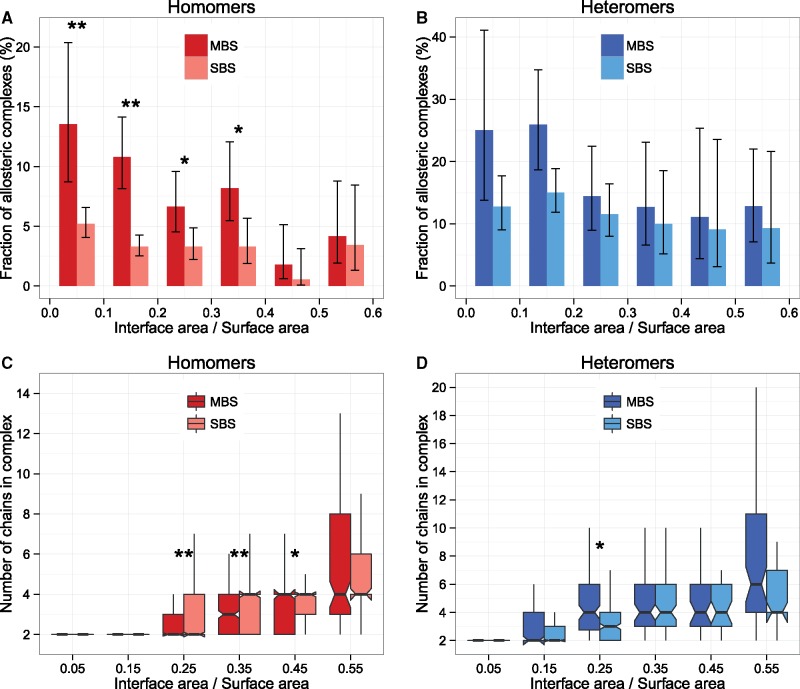
Allostery is more frequent in MBS homomers than in SBS homomers, irrespectively of their relative interface size. (A and B) The change of frequency of allostery with the interface-to-surface ratio (**P < 0.005, *P < 0.05, test of proportions, whiskers are 95% CI). (C and D) With increasing interface-to-surface ratio, the number of chains in protein complexes and also the size of complexes (supplementary fig. S4, Supplementary Material online) increases, both in homomers and heteromers (**P < 0.005, *P < 0.05, Wilcoxon tests). The declining trend seen on panels A and B is likely to be significantly influenced by experimental biases (and in consequence biases in the PDB): experimental methods like NMR have size limitations, MD simulations of large complexes are extremely time intensive, or dynamical properties are in general easier to determine for small complexes.